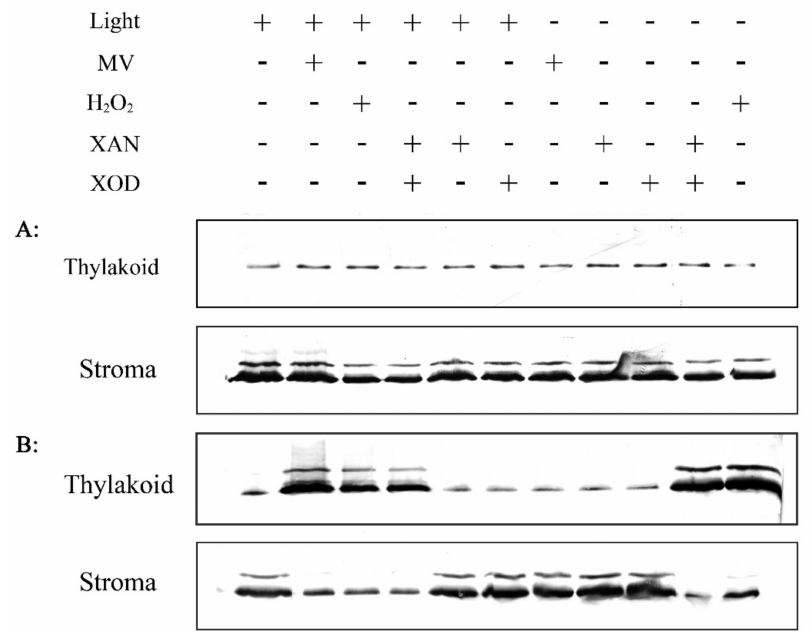
Figure 7. H 2 O 2 induced association of RCA with the thylakoid membrane. Chloroplasts were isolated fromleavesof O.meyeriana andthenrupturedbyosmoticshock. Thesuspensionofrupturedchloroplasts was treated with H 2 O 2 , methyl viologen (MV) or the xanthine (XAN)-xanthine oxidase (XOD) system, before the chloroplasts were sub-fractionated into soluble stroma and thylakoid membrane fractions followed by separation of RCA proteins while using SDS-PAGE. ( A ): Dalixiang, ( B ): O. meyeriana